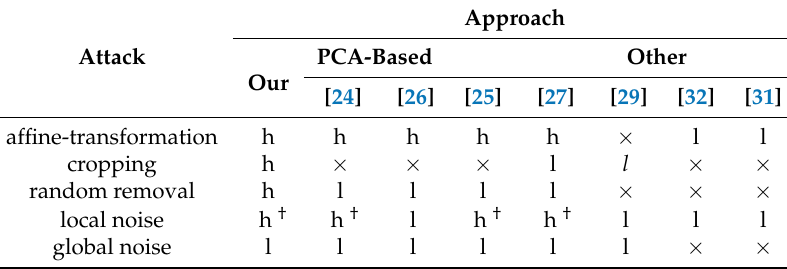
Table 1. The watermark robustness (h—high, l—low or non-robust (marked with )) against × various attacks. Approach Attack PCA-Based Other Our [24] [26] [25] [27] [29] [32] [31] affine-transformation h h h h h l l × cropping h l l × × × × × random removal h l l l l × × × local noise l l l l global noise l l l l l